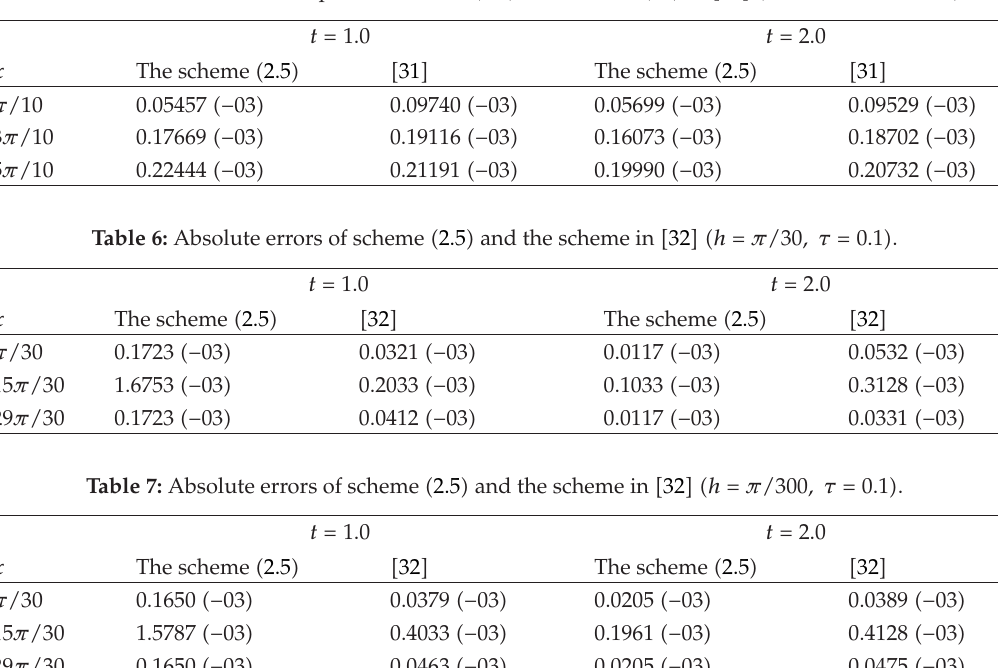
Table 5: Absolute errors of the present scheme (cid:3) 2.5 (cid:4) and scheme (cid:3) 16 (cid:4) in (cid:6) 31 (cid:7) (cid:3) h (cid:9) π/ 20 , τ (cid:9) 0 . 01 (cid:4) .